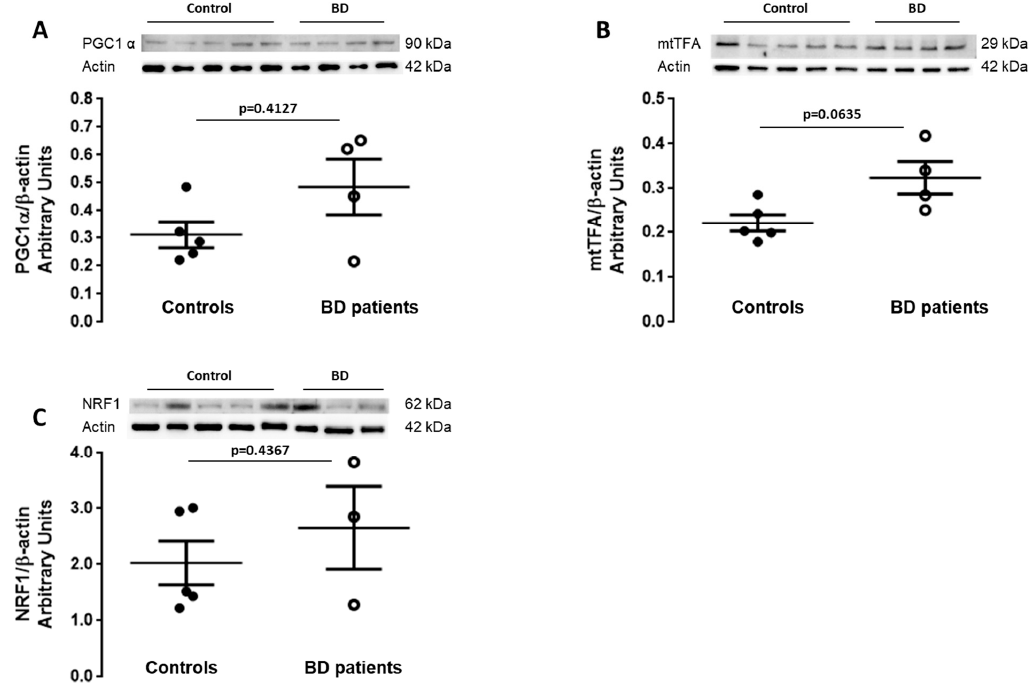
Figure 3. Mitochondrial biogenesis in BD patients’ fibroblasts. The protein levels of mediators of mitochondrial biogenesis ( A ) PGC1 α ( B ), mtTFA and ( C ) NRF1 were evaluated in fibroblasts from BD patients and control individuals through Western blot analysis. β -actin was used as loading control. The results were normalized to β -actin and expressed as mean ± SEM of 5 different control individuals and 4 BD patients. WB representative images correspond to BD and control samples analyzed on the same gel. A Mann–Whitney non-parametric test was used to statistical analysis.